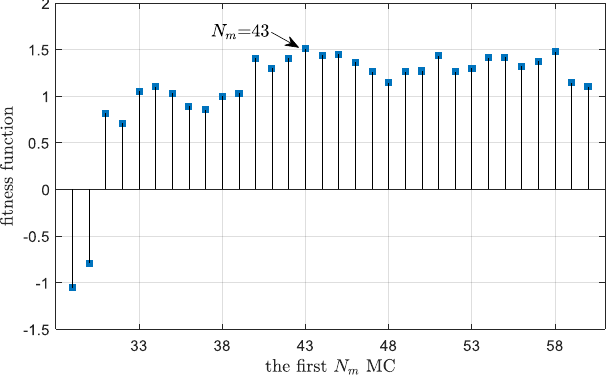
Figure 5. Fitness function of damage case A at a 3% level of noise for the least-squares method.